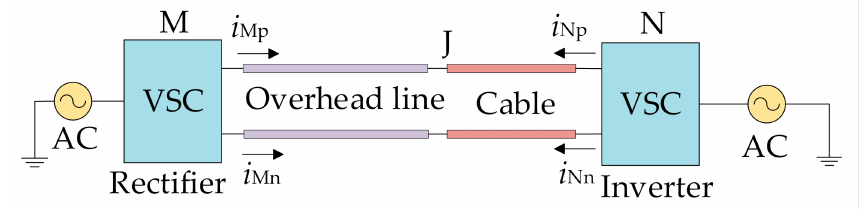
Figure 1. Hybrid two-segment voltage source converter–high voltage direct current (VSC-HVDC)